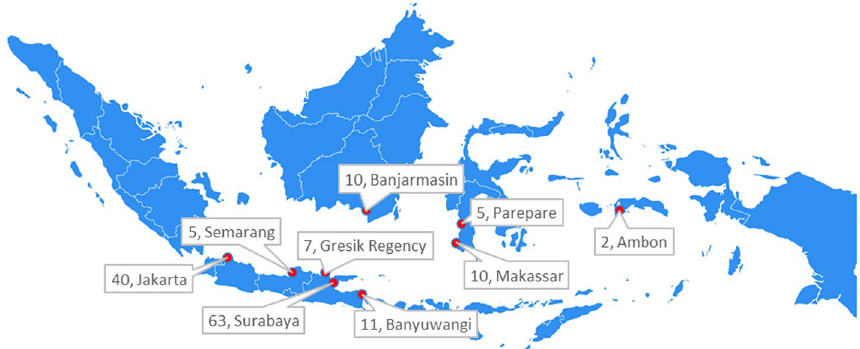
Fig. 1 The number of responses questionnaire per